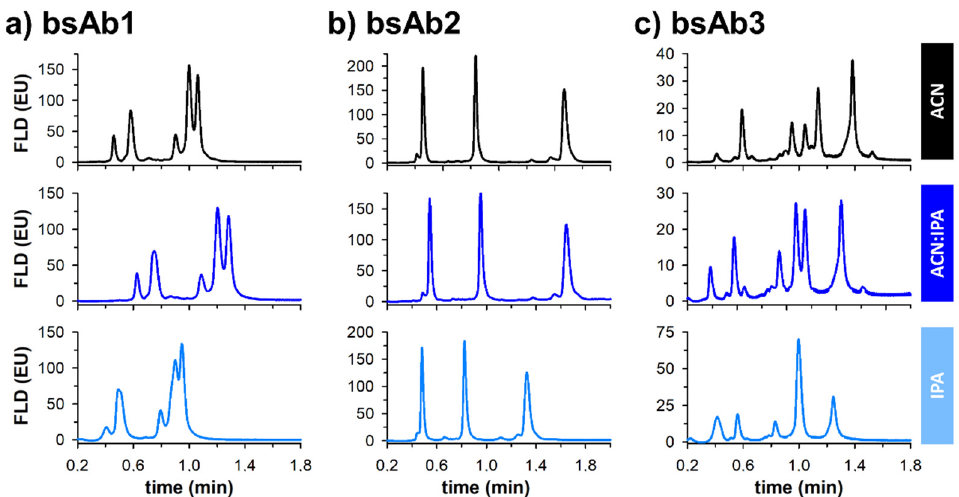
Figure 2. RPLC-Fluorescence chromatograms of the different bispecific antibodies (bsAbs), namely bsAb1 ( a ), bsAb2 ( b ), and bsAb3 ( c ), by using 3 different organic modifiers as mobile phase B, namely acetonitrile (ACN, black), 50:50 acetonitrile:isopropanol (ACN:IPA, blue), and isopropanol (IPA, cyan). Difluoroacetic acid (DFA) was used as the acid modifier in all mobile phases at a concentration of 0.05% ( v / v ).